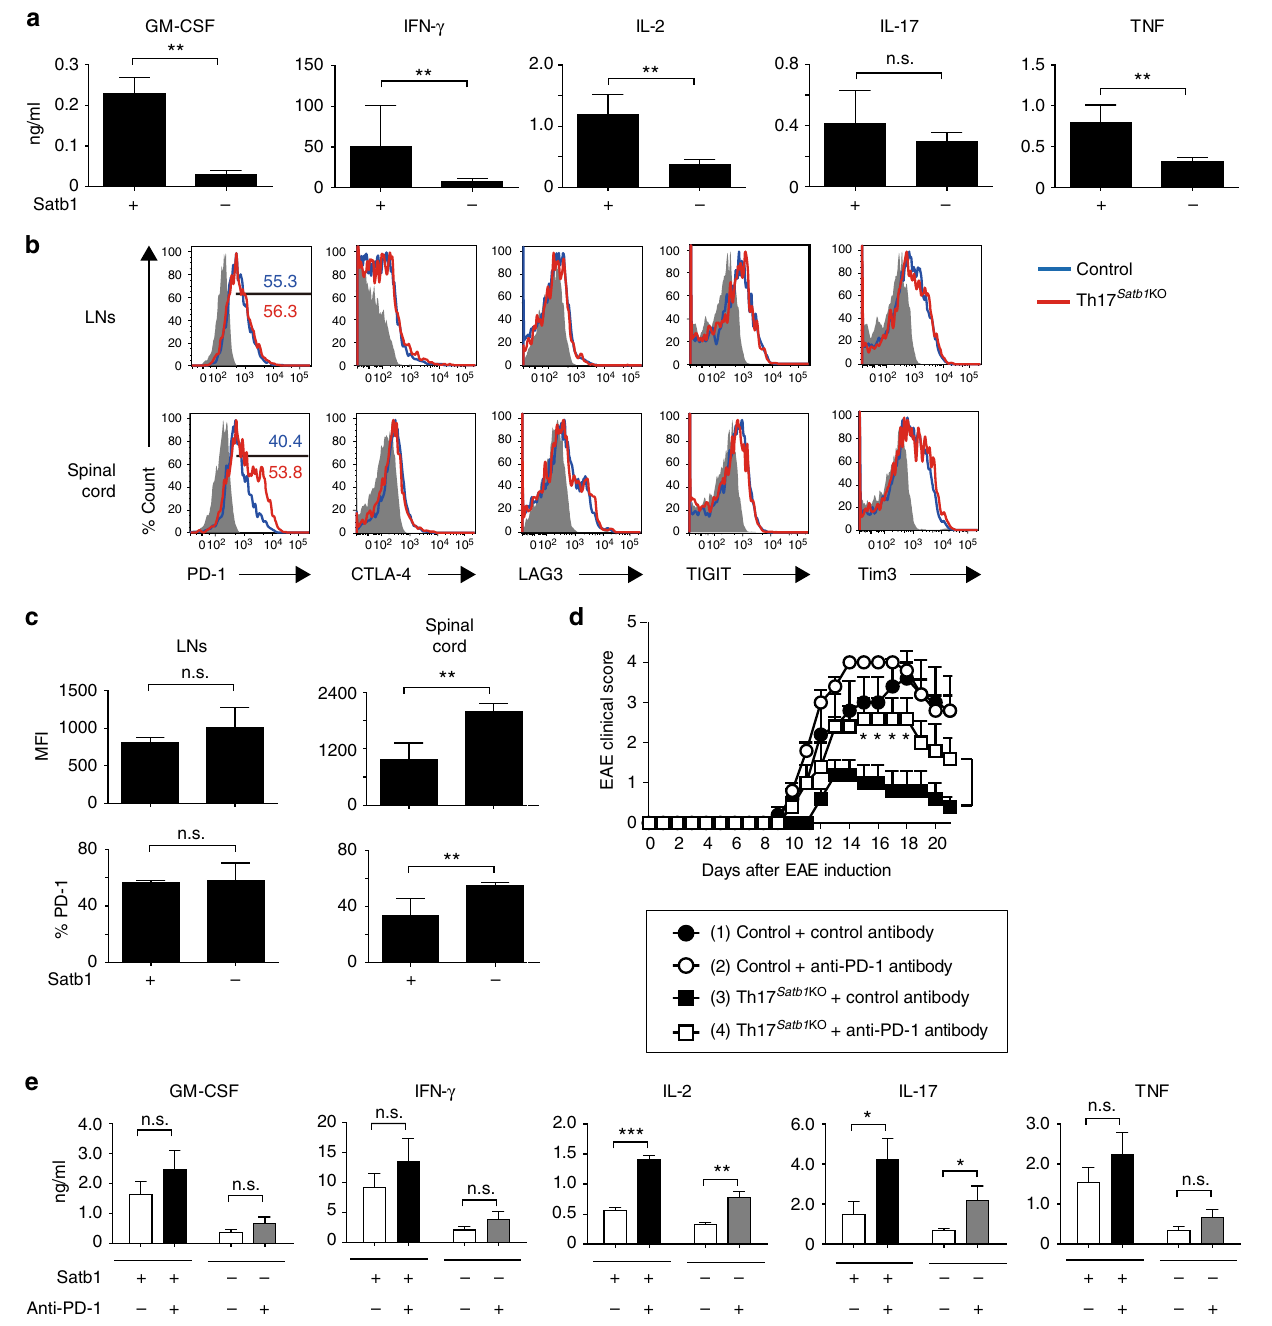
Fig. 6 Satb1 inhibits PD-1 expression by Th17 cells in the spinal cord. a Cytokine concentrations in the culture supernatant of re-stimulated Th17 cells are shown. eYFP + Th17 cells were sorted from the spinal cord of control or Th17 Satb1KO mice at the peak of EAE. Sorted Th17 cells were re-stimulated with BMDCs in the presence of MOG 35 – 55 peptide (50 μ g/ml) for 24 h. b , c Flow cytometry of draining LNs (day 7 after EAE induction) and spinal cord (day 14 ± 3 after EAE induction) eYFP + CD4 + T cells as in Fig. 2d for the expression of PD-1, CTLA-4, LAG3, TIGIT, and Tim3. The frequencies and mean fl uorescence intensity (MFI) of PD-1 + in eYFP + CD4 + T cells are shown ( c ). d The mean ( + s.e.m.) clinical scores on the days after EAE was induced in control or Th17 Satb1 KO mice, which were treated with the isotype-matched control (IgG2a) or anti-PD-1 mAbs ( n = 5). The incidence of EAE was as follows: (1) 5/5, (2) 5/5, (3) 4/5, and (4) 5/5. * P < 0.05 (two-way ANOVA with Bonferroni ’ s post-test). e Cytokine concentrations in the culture supernatant of re- stimulated Th17 cells are shown. eYFP + Th17 cells were sorted from the spinal cord of control or Th17 Satb1KO mice at the peak of EAE and then re- stimulated with BMDCs in the presence of MOG 35 – 55 peptide (50 μ g/ml) with or without the PD-1 antibody (20 μ g/ml) for 24 h. The bar graphs ( a , c , e ) show the mean ± s.d. ( n = 3). The results are representative of three independent experiments. * P < 0.05; ** P < 0.001; *** P < 0.0001 (two-tailed unpaired Student ’ s t